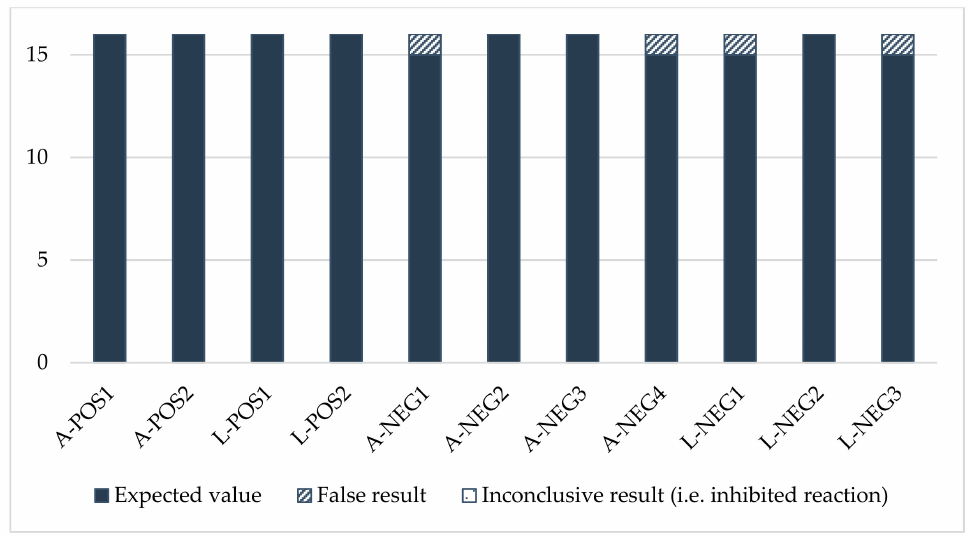
Figure A2. Consistency of the PCR results. Table A3. Individual performance scores for morphology and PCR. Morphology PCR Lab Code Acc 1